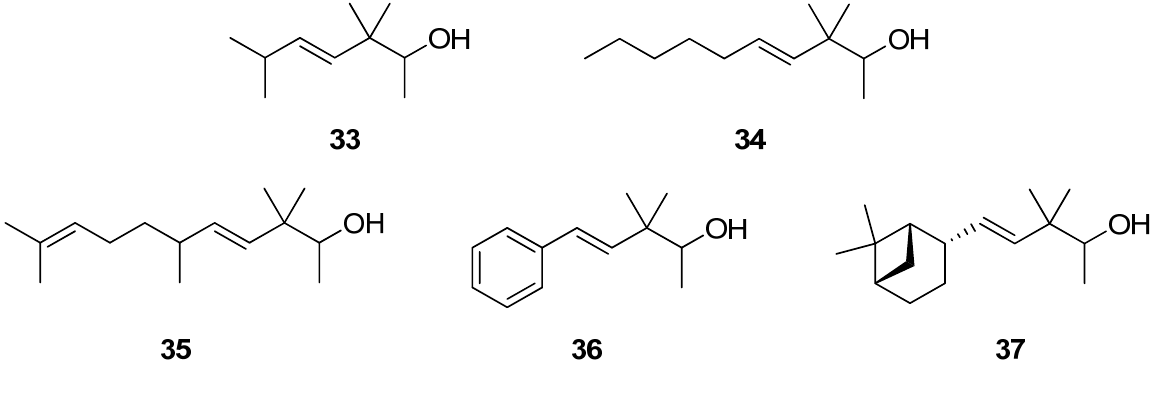
Figure 3. The target analogues of the sandalwood odorant Polysantol ®